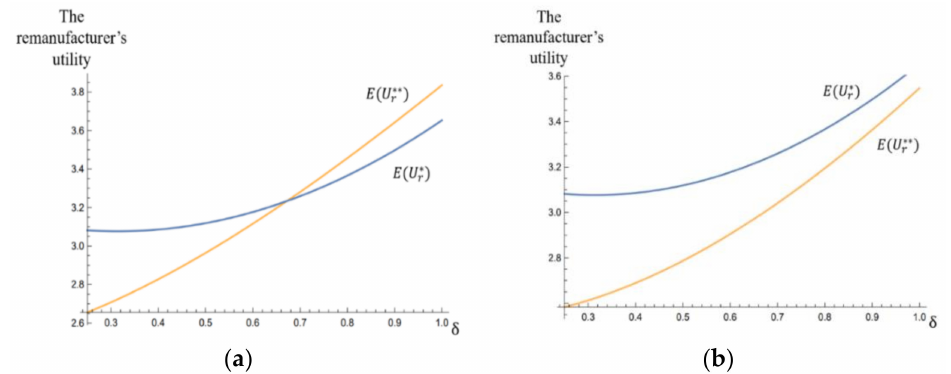
Figure 6. The e ff ects of the unit subsidy δ on the remanufacturer’s utilities E ( U ∗ r ) and E ( U ∗∗ r ) ( a ) with the highest fixed payment α = 4, and ( b ) with the highest fixed payment α =